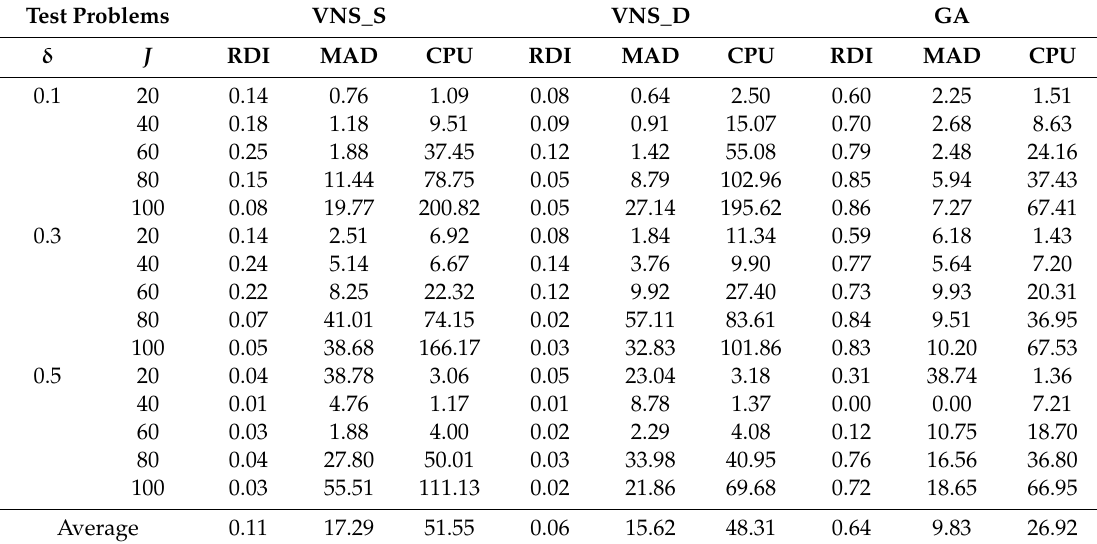
Table 5. Test results of large-sized